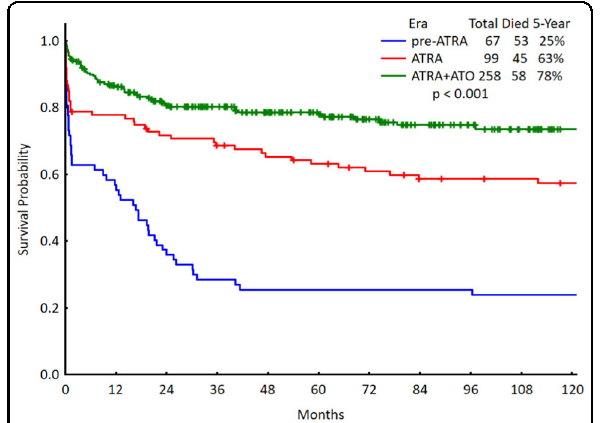
Fig. 3 Survival of core-binding factor acute myeloid leukemia at MD Anderson (1970 –